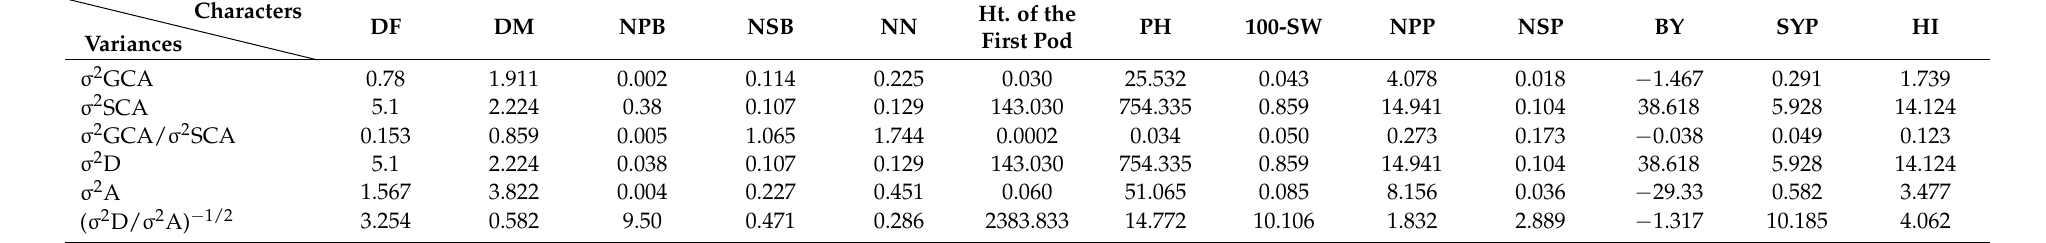
Table 5. Fixed types of variances for various characters in field pea.